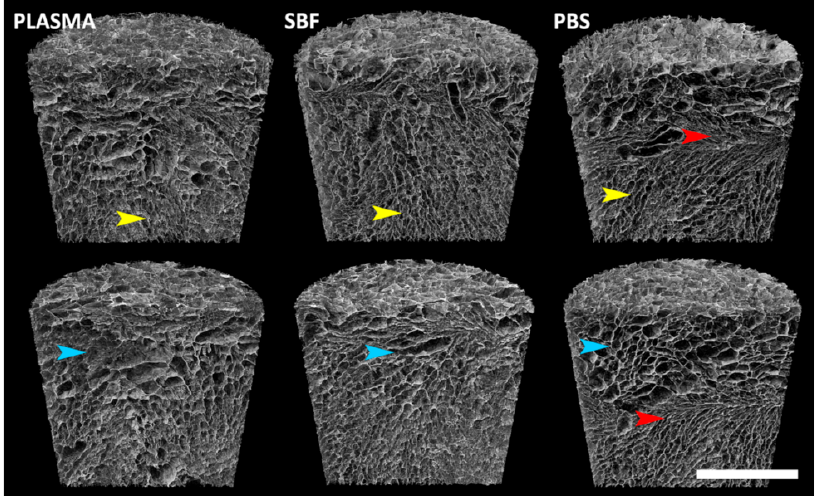
Figure 5. Micro-CT 3D visualizations of representative specimens from each group. The upper images were taken prior to media exposure, while the lower images show the same specimens following media exposure. No apparent structural changes occurred. The structure is not strictly homogeneous. Various areas in each of the specimens are highlighted: small pores (yellow), large pores (blue), condensed area (red). Scale bar = 2